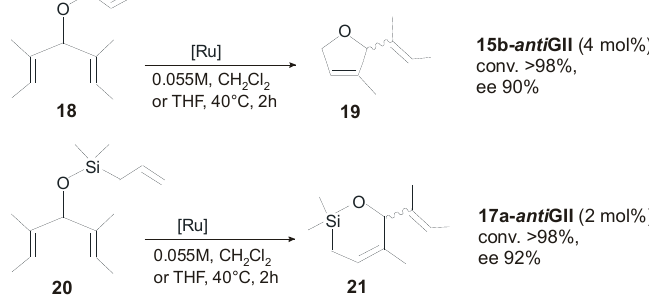
Figure 13. Catalysts 16-GII – 18-GII bearing monodentate NHCs with anti backbone.